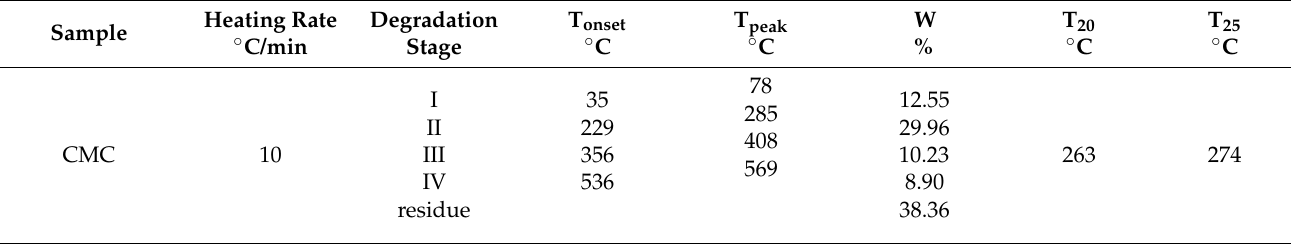
Figure 6. ( a ) TG and ( b ) DTG curves of CMC and CMC/PA hydrogels and ( c ) the residual percentage depending on the amount of PA in the synthesis. Table 2. Thermal parameters of CMC and CMC/PA hydrogels.